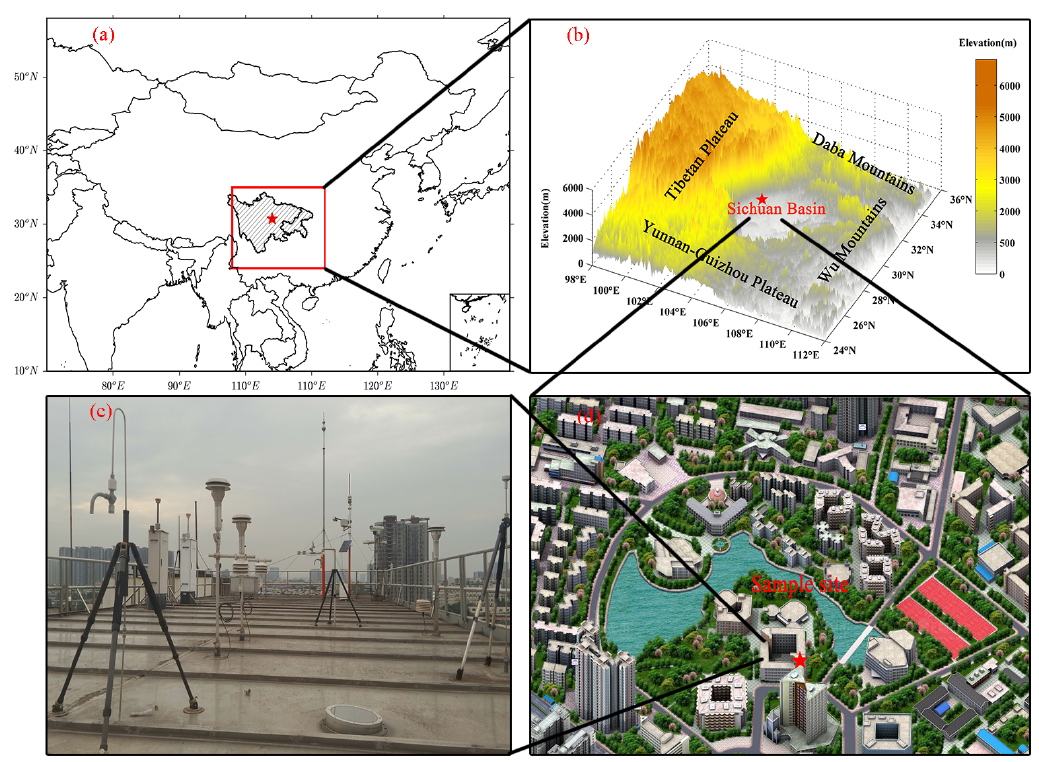
Figure 1. ( a ) Locations of the metropolitans of Chengdu-Chongqing; ( b ) Location of the Sichuan Basin and its elevation; ( c , d ) Location of the synergistic suite.